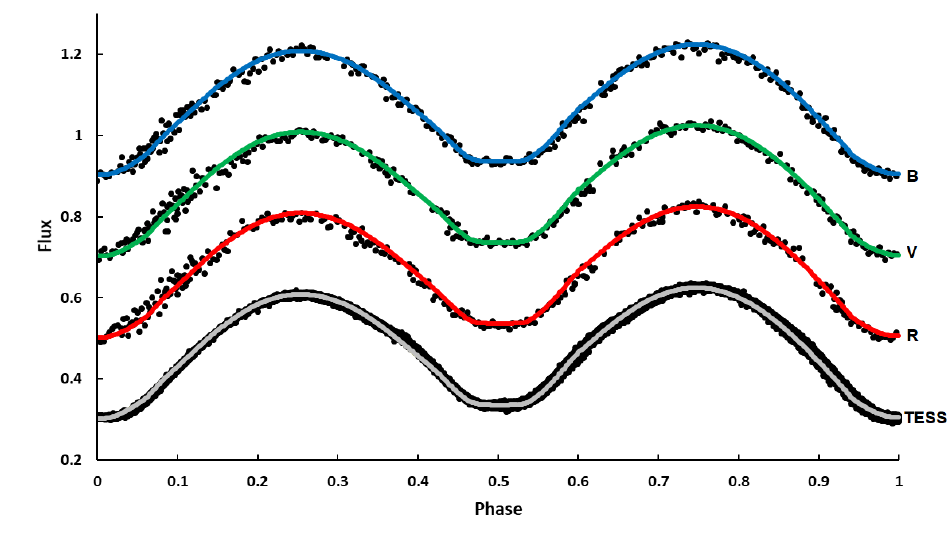
Fig. 4. Light curves from our observations and TESS (black dots). The synthetic light curves obtained from light curve solutions in the BVI filters and TESS are shown (top to bottom respectively); with respect to orbital phase, shifted arbitrarily in the relative